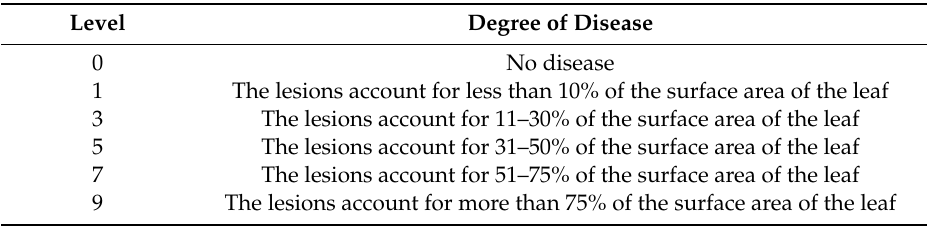
Table 3. Grading criteria for the incidence of pepper leaves.